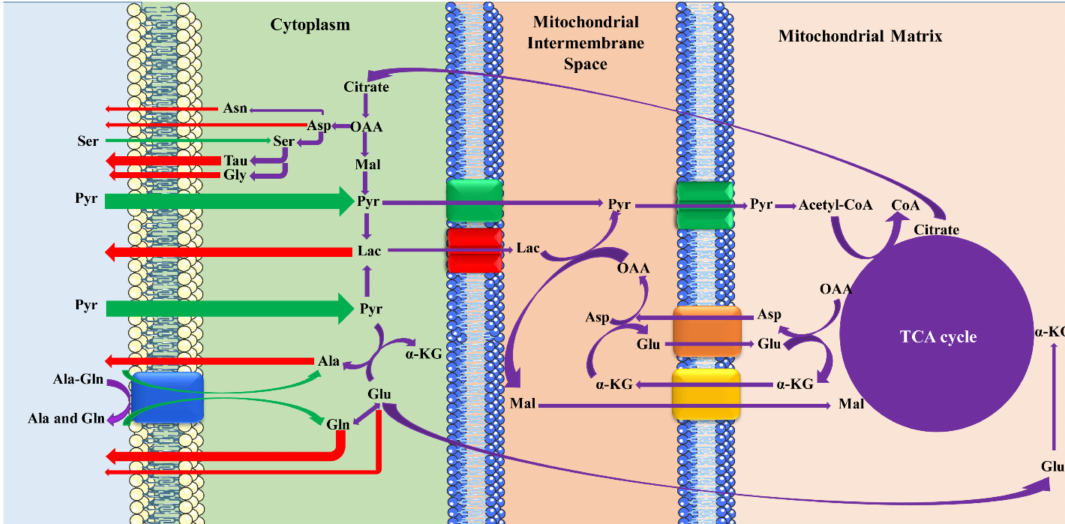
Figure 4. Summary of the proposed mechanism among the metabolites on the fifth day of embryo development. Pyr and Lac transfer through H + -monocarboxylate cotransporters. Ala-Gln may be uptaken within the cells by the AA transporter after hydrolyzation by peptidase into its constituents. Entrance, exit and intercellular interactions of di ff erent metabolites have been illustrated in green, red and violet arrows, respectively. TCA: tricarboxylic acid, OAA: oxaloacetic acid, α -KG: α -ketoglutarate, Mal: